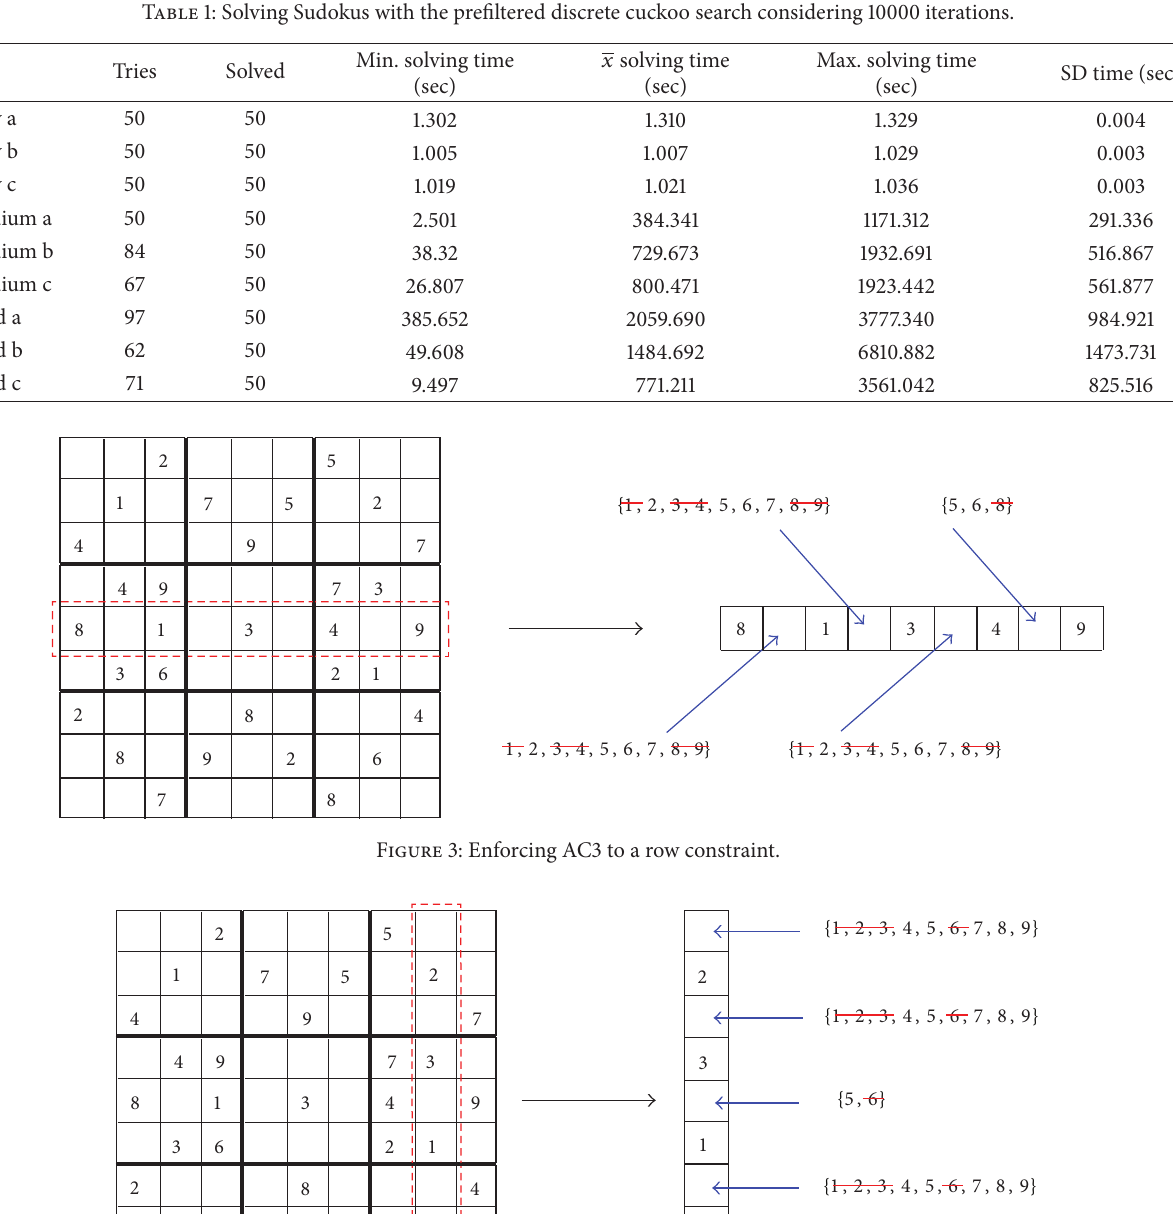
Table 1: Solving Sudokus with the prefiltered discrete cuckoo search considering 10000 iterations.